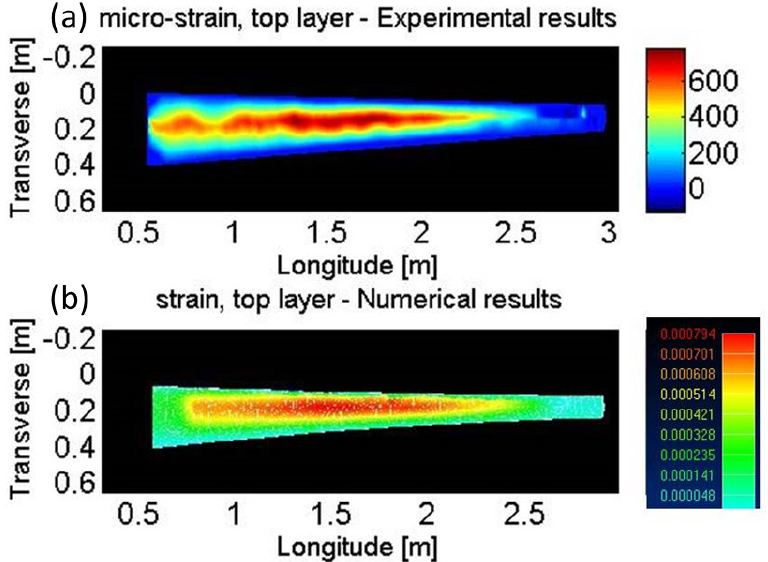
Figure 9. Strain profiles across the upper surface of a composite model wing of an unmanned aerial vehicle subject to a static loading of 550 N. ( a ) Strain map extrapolated from high-resolution phase-coded B-OCDA traces [26]. ( b ) Predicted strain map obtained by numerical, structural analysis [26]. Reproduced with permission from [26], MDPI, 2017 .